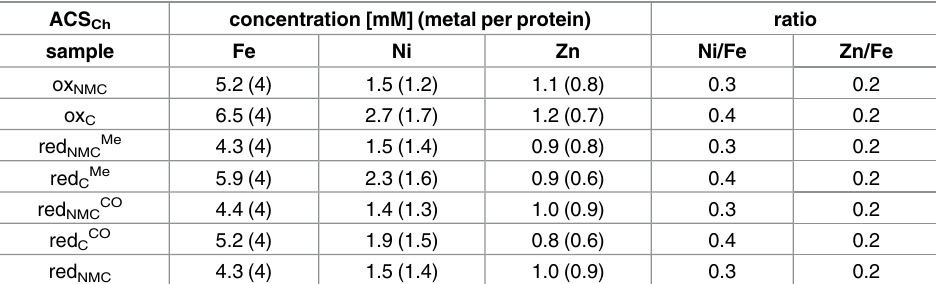
a Concentrations (error ± 0.5 mM) are for oxidized (ox) or reduced (red) Ni-reconstituted ACS comprising the N-, middle, and C-terminal domains (NMC) or only the C-terminal domain (C) and the indicated cofactor modifications (CO = carbon monoxide treatment, Me = methyl-cobinamidetreatment). Values in parenthesis show metal-to-protein ratios calculated under the assumption that four iron ions in the [4Fe4S] cluster are present in both ACS Ch variants irrespective of the occupation of the nickel binding sites. The protein concentration was estimated as 1.0 ± 0.2 mM in all samples.